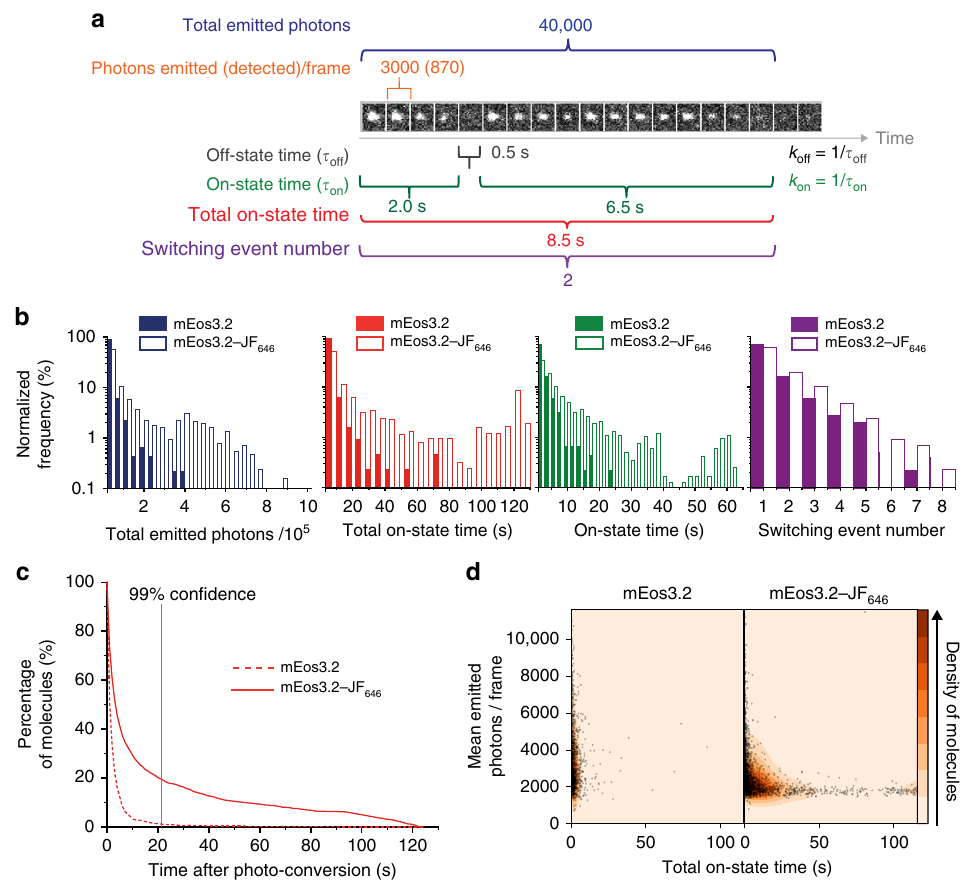
Fig. 2 Improved photophysics of FRET-enhanced mEos3.2. a A representative trace of mEos3.2 – JF 646 is shown as a montage of single frames over time. Photons detected were converted to photons emitted per on frame and summed to determine the total photon emission. The on-state time was calculated per switching event and summed to generate the total on-state time. The number of switching events was also calculated. b Histograms of total emitted photons, total on-state time, on-state time (i.e., individual track length), and total number of switching events per molecule, when performing single- molecule TIRF imaging using either mEos3.2 ( fi lled bars) or the mEos3.2 – JF 646 FRET pair (open bars) under identical imaging conditions. c The increase in total on-state time that occurred upon addition of the JF 646 dye is shown with a vertical line to illustrate that more than 20% of the mEos3.2 – JF 646 molecules are still on when 99% of the mEos3.2 molecules are off. d At a single-molecule level, molecules with the longest total on-state times also had the lowest average intensity (i.e., highest FRET ef fi ciency) measured as emitted